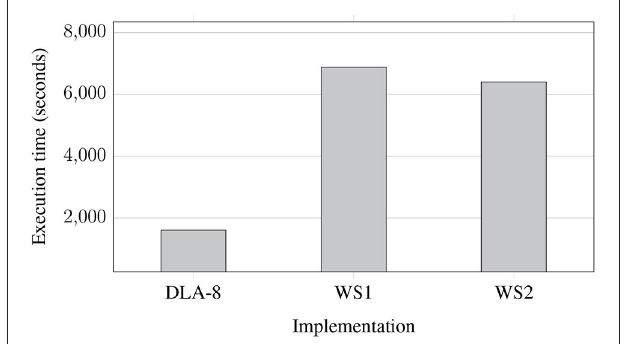
FIGURE 7 | Processing times of NGS data extracted from regular uncompressed FASTQ files and saved to eight uncompressed FASTQ files (two files for each of the processed genomes) for various implementations: on Data Lake with 8 AUs (DLA-8), workstation 1 (WS1), and workstation 2 (WS2).